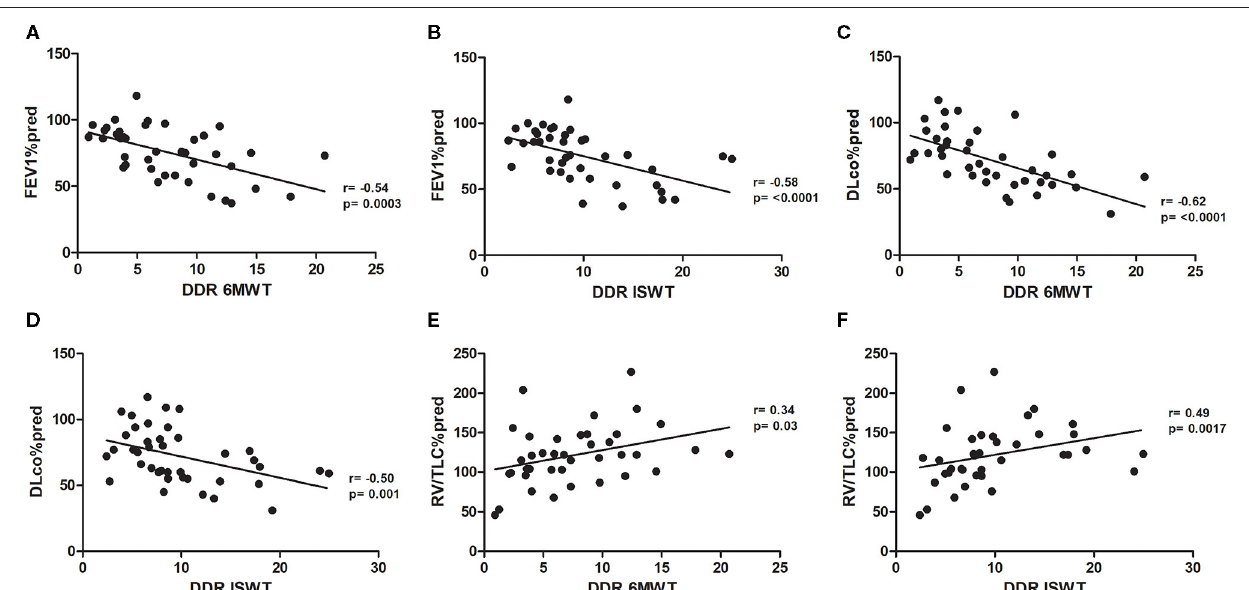
FIGURE 2 | (A) Pearson’s correlation between FEV1%pred and DDR 6MWT. (B) Pearson’s correlation between FEV1%pred and DDR ISWT. (C) Pearson’s correlation between DL CO %pred and DDR 6MWT. (D) Pearson’s correlation between DL CO %pred and DDR ISWT. (E) Pearson’s correlation between RV/LTC%pred and DDR 6MWT. (F) Pearson’s correlation between RV/LTC%pred and DDR ISWT. FEV1%pred, forced expiratory volume in 1s as a percentage of predicted; DDR, desaturation distance ratio; 6MWT, 6-min walking test; ISWT, incremental shuttle walking test; DL CO , diffusing capacity of the lung for carbon monoxide as a percentage of predicted; RV, residual volume; TLC, total lung capacity.